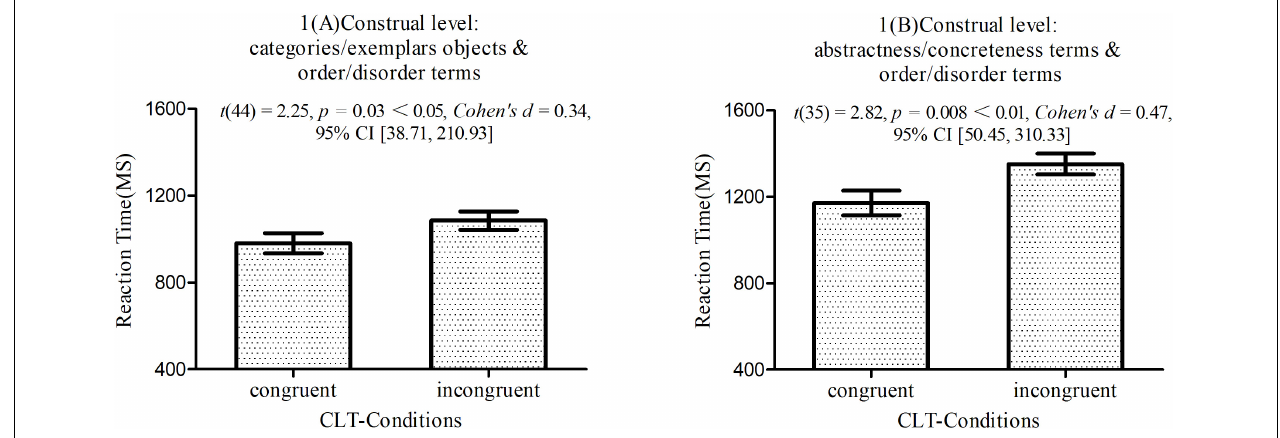
FIGURE 2 | Response times for congruent and incongruent orderliness-construal level pairings for studies 1A and 1B. The differences between the conditions were significant in both experiments. Error bars represent 2